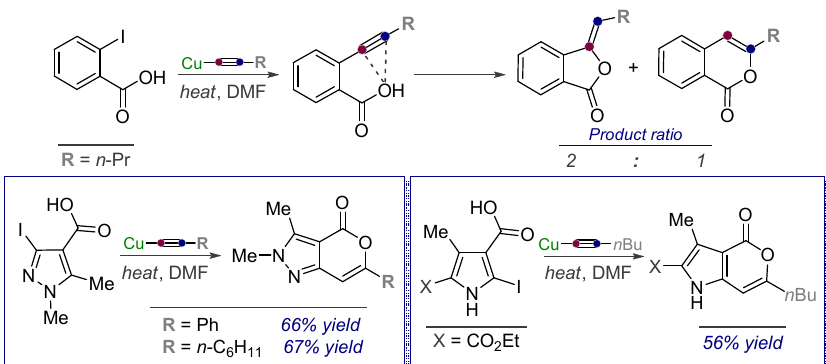
Scheme 18. Top: The cyclization of o-carboxy acetylenes, formed via cuprate addition, prefers the 5-exo-dig pathway. Bottom: Regioselective 6-endo-dig cyclizations of acetylenic carboxylates at five-membered rings.